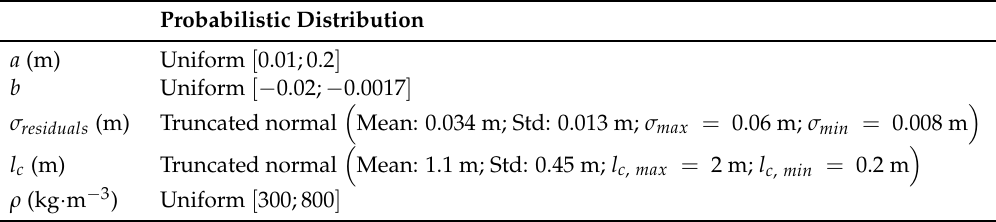
Table 6. Probabilistic distributions of the randomised parameters of bio-colonisation thickness.